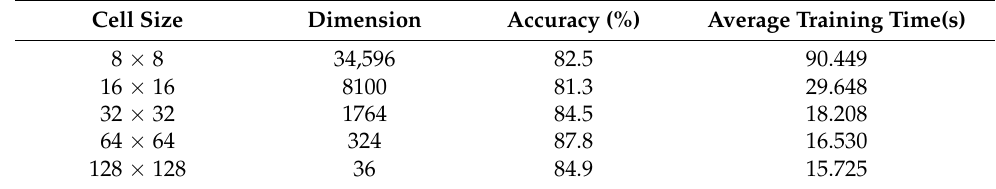
Table 2. Experimental results of histogram of oriented gradient (HOG) feature with different cell sizes. Cell